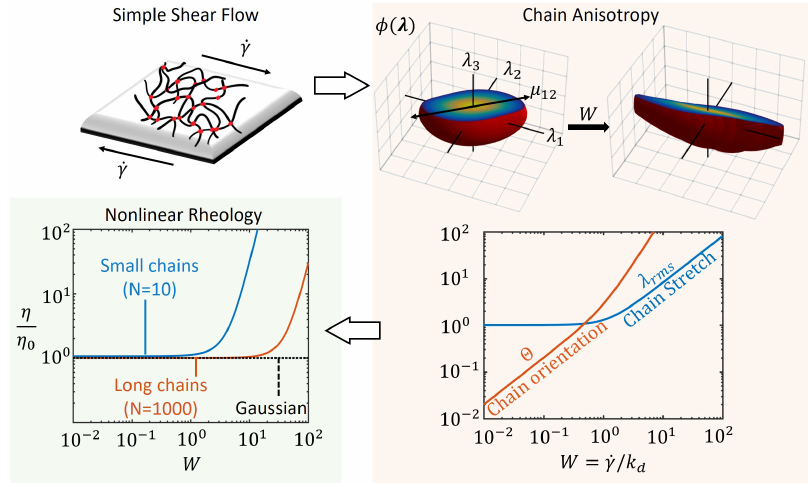
Figure 3. Steady shear flow of a transient polymer network shown leading to chain anisotropy at steady state as seen from chain distribution function, φ ( r ) for different values of the Weissenberg number, W . The average chain stretch, λ rmd , and orientation, Θ , are obtained from the chain distribution tensor, µ as a function of W . The nonlinear rheology is then captured by the plot of non-dimensional viscosity η / η 0 , where η 0 = ck B T / k d is the viscosity of the network at zero